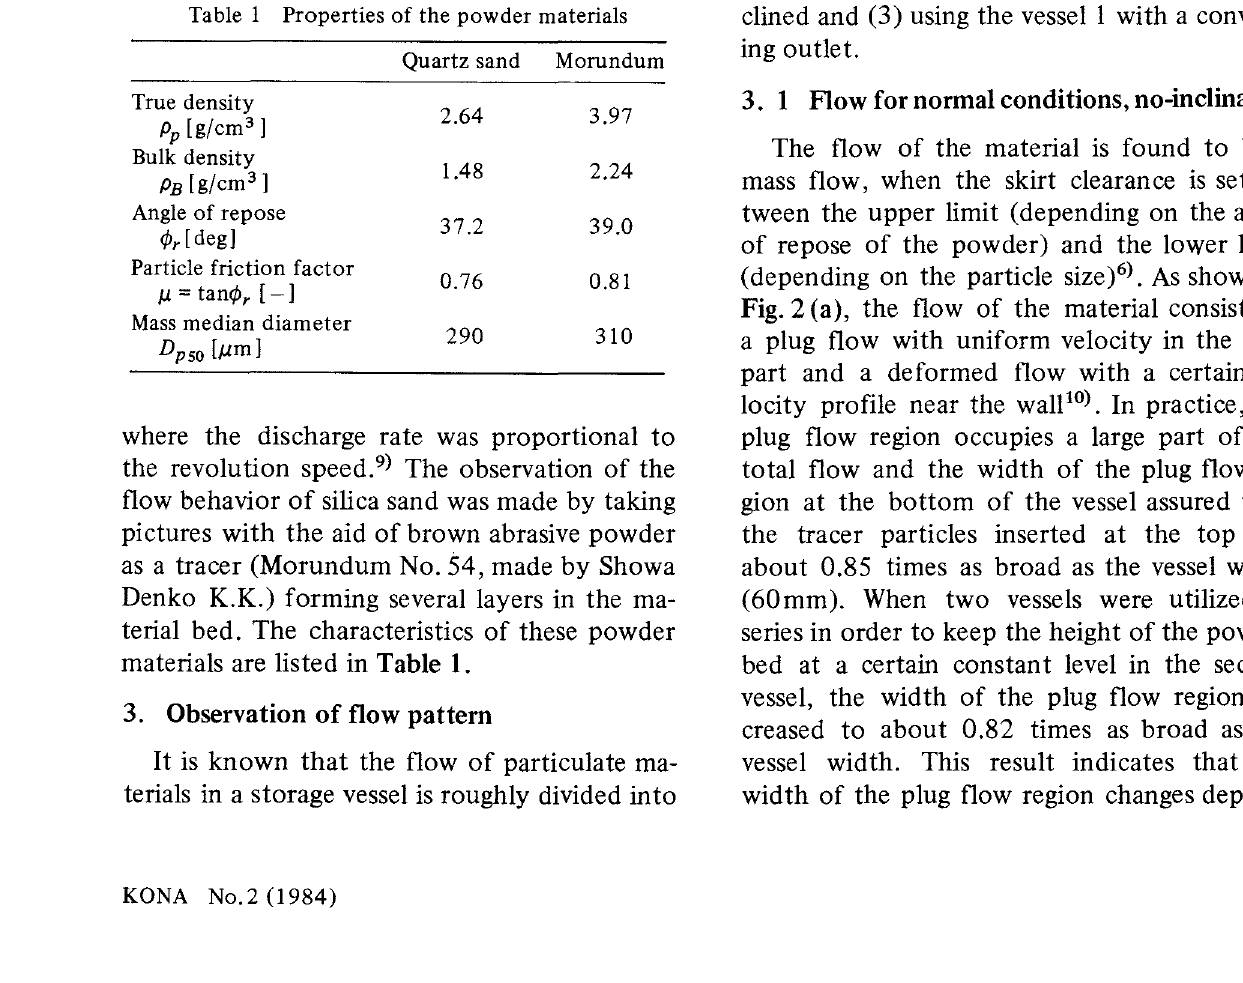
Fig. 1 Schematic diagram of experimental apparatus Table 1 Properties of the powder materials